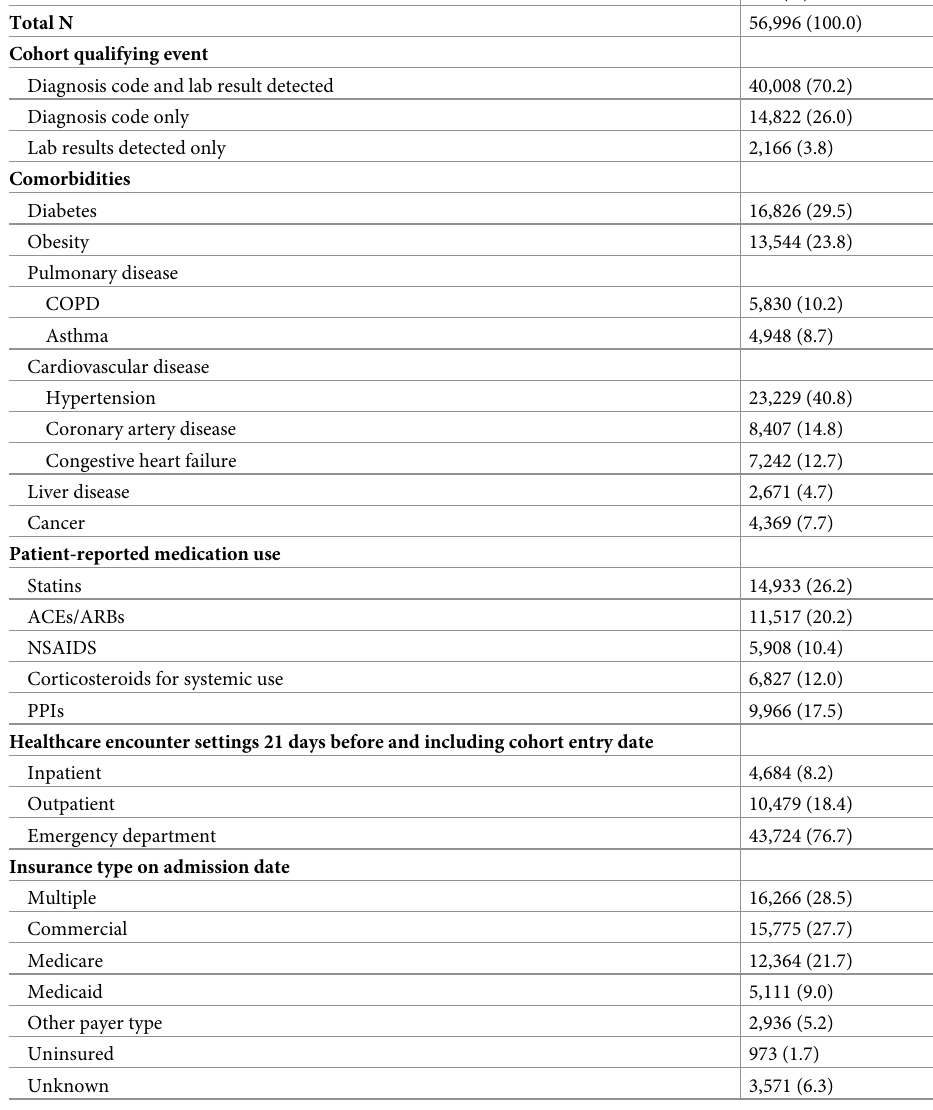
Table 1. Demographics and comorbidities among hospitalized patients with COVID-19 a